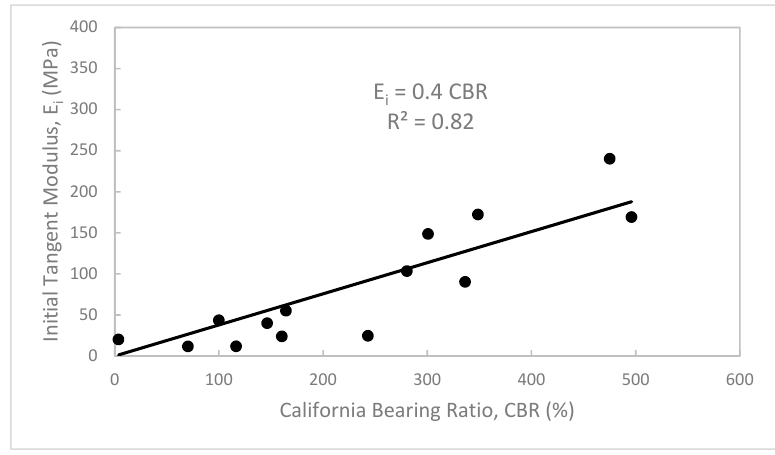
Figure 16. Initial tangent modulus (E i ) vs. California bearing ratio (CBR value) of the treated waste sand.